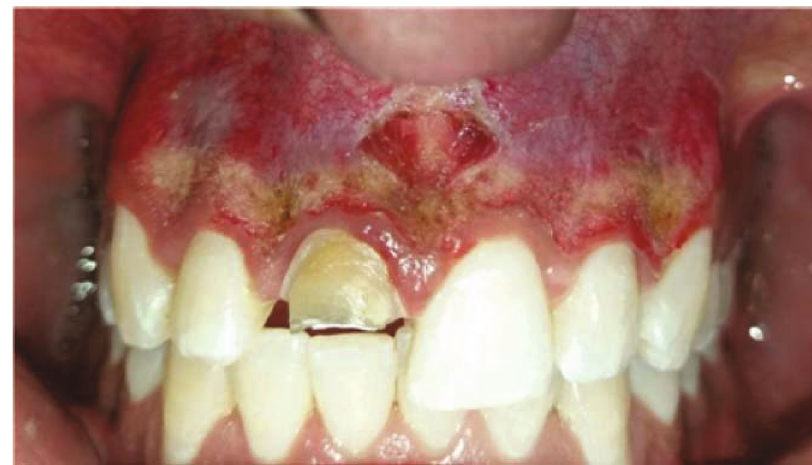
Figure 2: Clinical appearance immediately after the diode laser procedure and labial